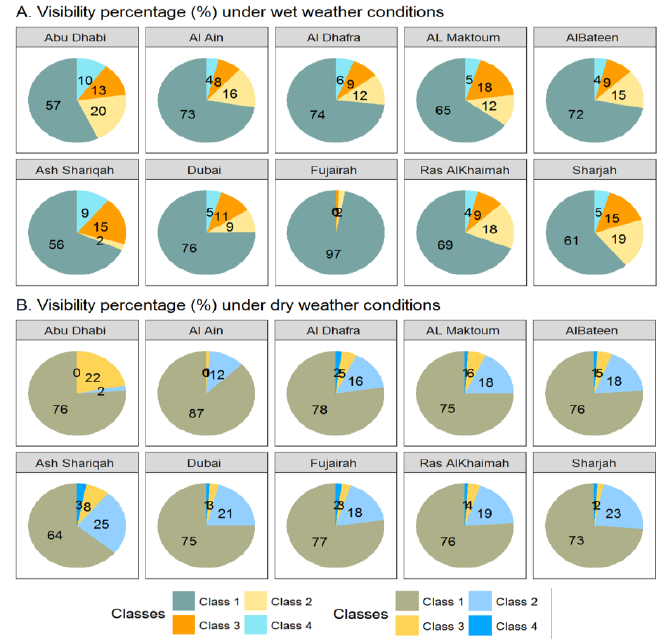
Figure 4. Low visibility caused by ( A ) wet and ( B ) dry weather conditions per visibility class, per station (%).